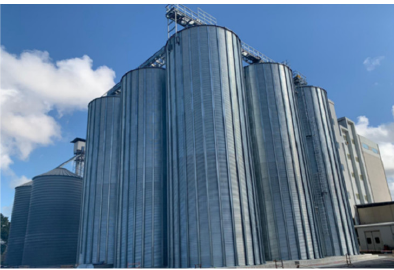
Figure 2. View of silos battery used for grain storage with capacity of 3955 tons (Campo San Martino, Italy).